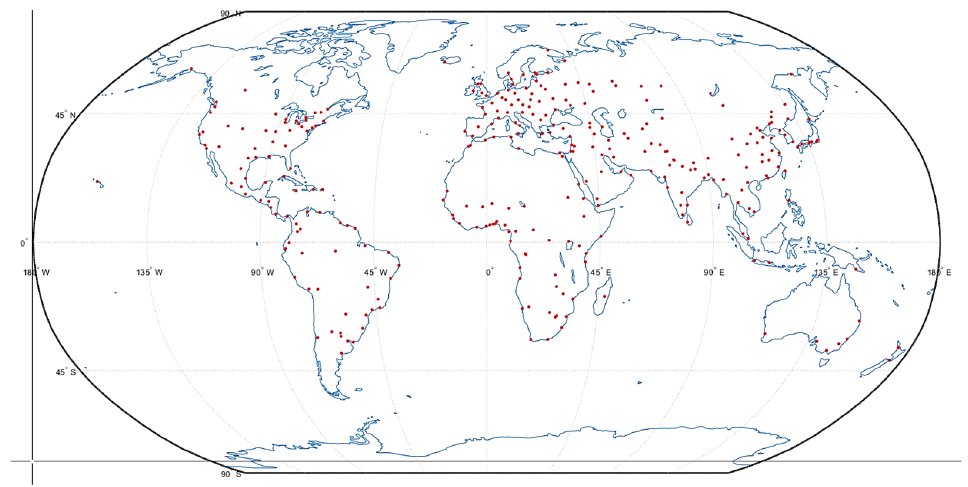
Figure 2. Choosing the departure and arrival points on the map. When both the parameters latitude (LAT) and longitude (LONG) have been identified for the chosen points, the program elaborates a 400 ∗ 200 matrix, which identifies all possible LAT-LONG combinations for the ship position on the map during its transfer (an example of this matrix is provided in Figure 3).